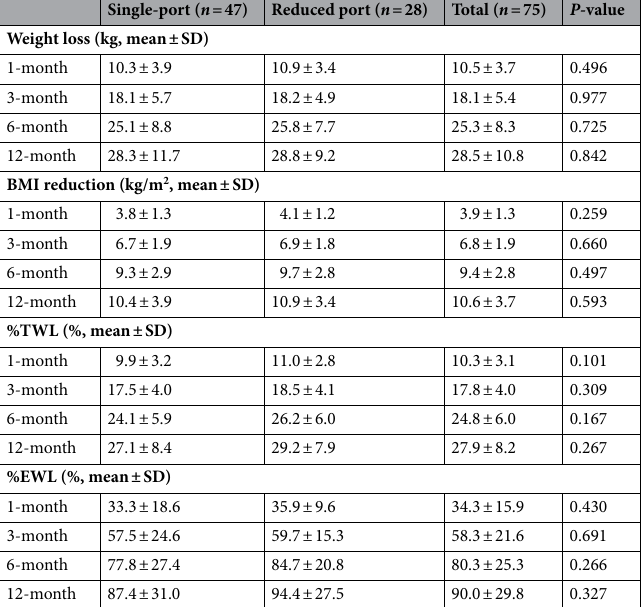
Table 3. Subgroup analysis of single-port and reduced-port laparoscopic sleeve gastrectomy patients for weight loss at 1, 3, 6, and 12-month follow-up after surgery. BMI body mass index, %TWL percent of